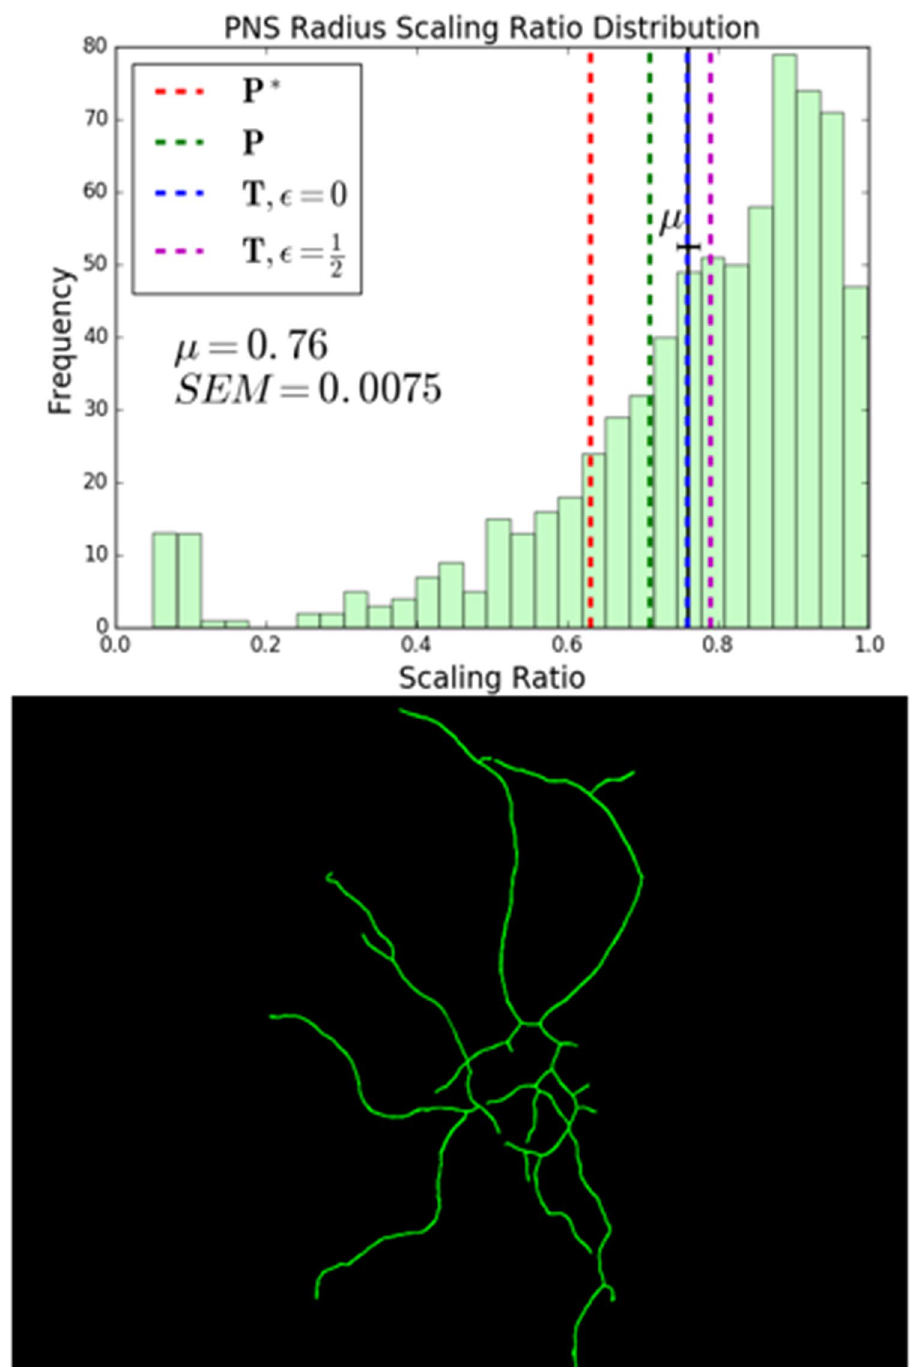
Figure 4. Peripheral nervous system neurons. A histogram showing the distribution of radius scaling ratios in Peripheral Nervous System (PNS) neurons, along with a representative image of the dendritic tree of a mouse sensory neuron 55 . We observe an average radius scaling ratio of 0.76 ± 0.01 . In the figure, µ represents the mean and SEM represents the standard error of the mean. The standard deviation of the distribution is 0.20. We have restricted radius scaling ratio data to values that are less than 1.0. The black solid lines denote the mean in the distributions, shown with error bars, and the red, green, blue, and magenta dashed lines represent the theoretical predictions for various objective functions. The closest theoretical prediction is n − 2 / 5 ≈ 0.76 , the optimal scaling ratio for the function T that minimizes time delay for unmyelinated fibers, ǫ = 0